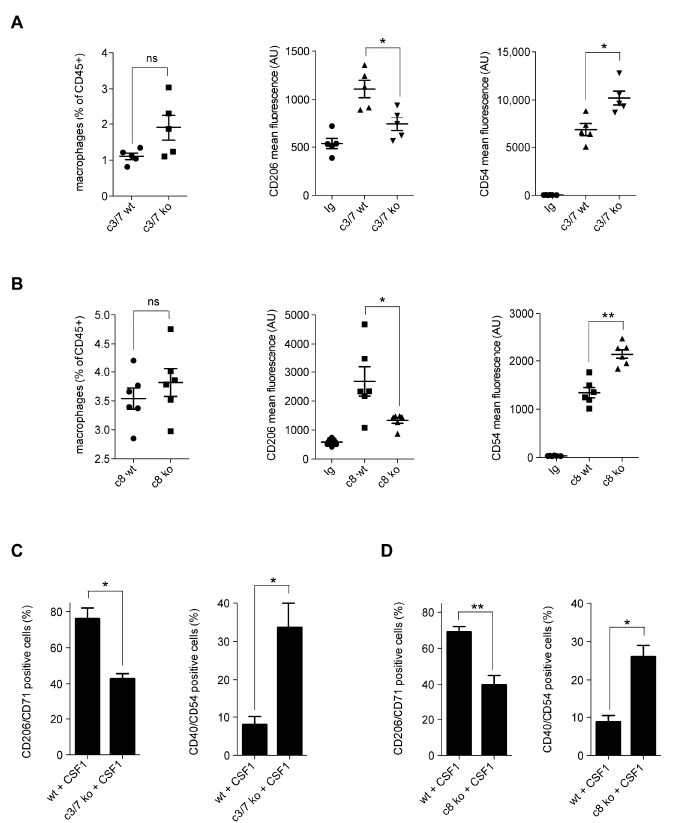
Figure 1. Macrophage alterations in monocyte-restricted caspase knockout mice. ( A , B ) Interstitial macrophages were sorted from the lung of monocyte-restricted caspase-3/7 double knockout (LysM-Cre/Casp3/7 fl/fl ) or caspase-8 knockout (LysM-Cre; Casp8 fl/fl ) mice or wild-type (wt) animals. Interstitial macrophages were selected according to their larger size (FSC) and granularity (SSC) as CD45 + , GR1 − , CD11b high , SiglecF − , IA-IE + , CD24 − cells. ( A ) Left panel, number of interstitial macrophages, expressed as percent of CD45 + cells, in wild-type and LysM-Cre/Casp3/7 fl/fl mice (c3/7 ko). Flow cytometry analysis of cell surface markers CD206 (middle panel) and CD54 (right panel) expressed as mean fluorescence intensity (*, p < 0.05; ns, non-significant; Mann–Whitney test, n = 5 per group). Mean ± SE. ( B ) Left panel, number of interstitial macrophages, expressed as percent of CD45 + cells, in wild-type and LysM-Cre; Casp8 fl/fl mice (c8 ko). Flow cytometry analysis of cell surface markers CD206 (middle panel) and CD54 (right panel) expressed as mean fluorescence intensity (*, p < 0.05; **, p < 0.01; ns, non-significant; Mann–Whitney test, n = 6 per group). Mean ± SE. ( C , D ) Bone marrow cells were flushed from mouse femurs and tibias of LysM- Cre/Casp3/7 fl/fl ( C ) or LysM-Cre; Casp8 fl/fl mice ( D ) or wild-type (wt) animals before sorting CD115 + /CD11c − /NK − monocytes. These cells were cultured in the presence of 100 ng/mL CSF1 for 5 days before multiparameter flow cytometry analysis. Left panels show the percentage of CD206 + /CD71 + macrophages. Right panels indicate the percentage of CD40 + /CD54 + macrophages (*, p < 0.05; **, p < 0.01; Mann–Whitney test, n = 4). Mean ±